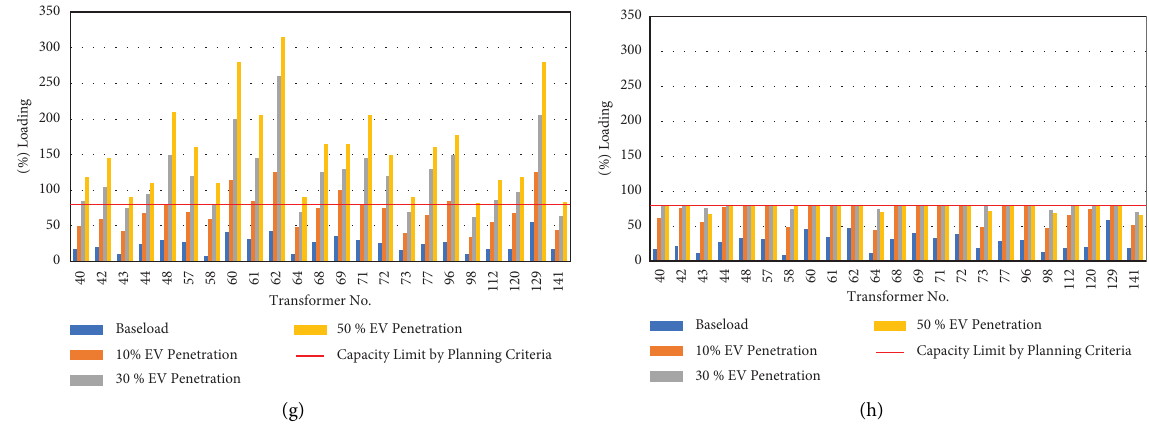
Figure 12: Comparison of percent loading of distribution transformers under primary feeders no. 1–4 with the three scenarios of EV penetration between uncoordinated and smart charging. Distribution transformers overloaded connected at feeder 1 (a) uncoordinated charging (b) smart charging. Distribution transformers overloaded connected at feeder 2 (c) uncoordinated charging (d) smart charging. Distribution transformers overloaded connected at feeder 3 (e) uncoordinated charging (f) smart charging. Distribution transformers overloaded connected at feeder 4 (g) uncoordinated charging (h) smart